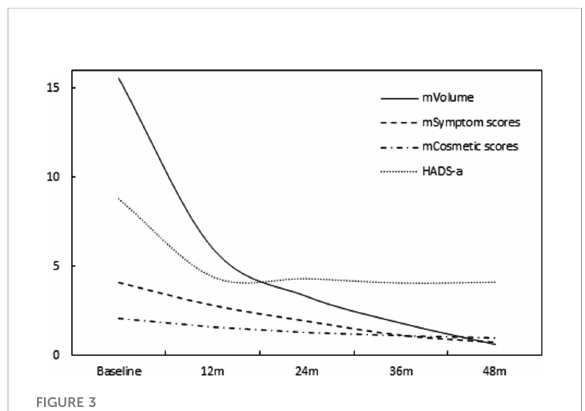
FIGURE 3 At each follow-up time point, the symptoms and cosmetic scores and HADS-a varied with thyroid nodule